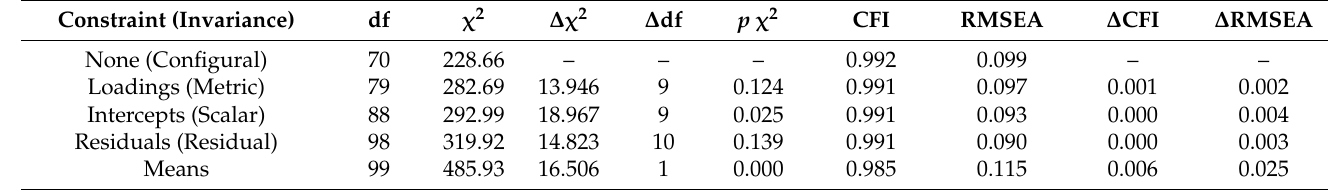
Table 4. Indices of measurement invariance of the CCWS for women and men.